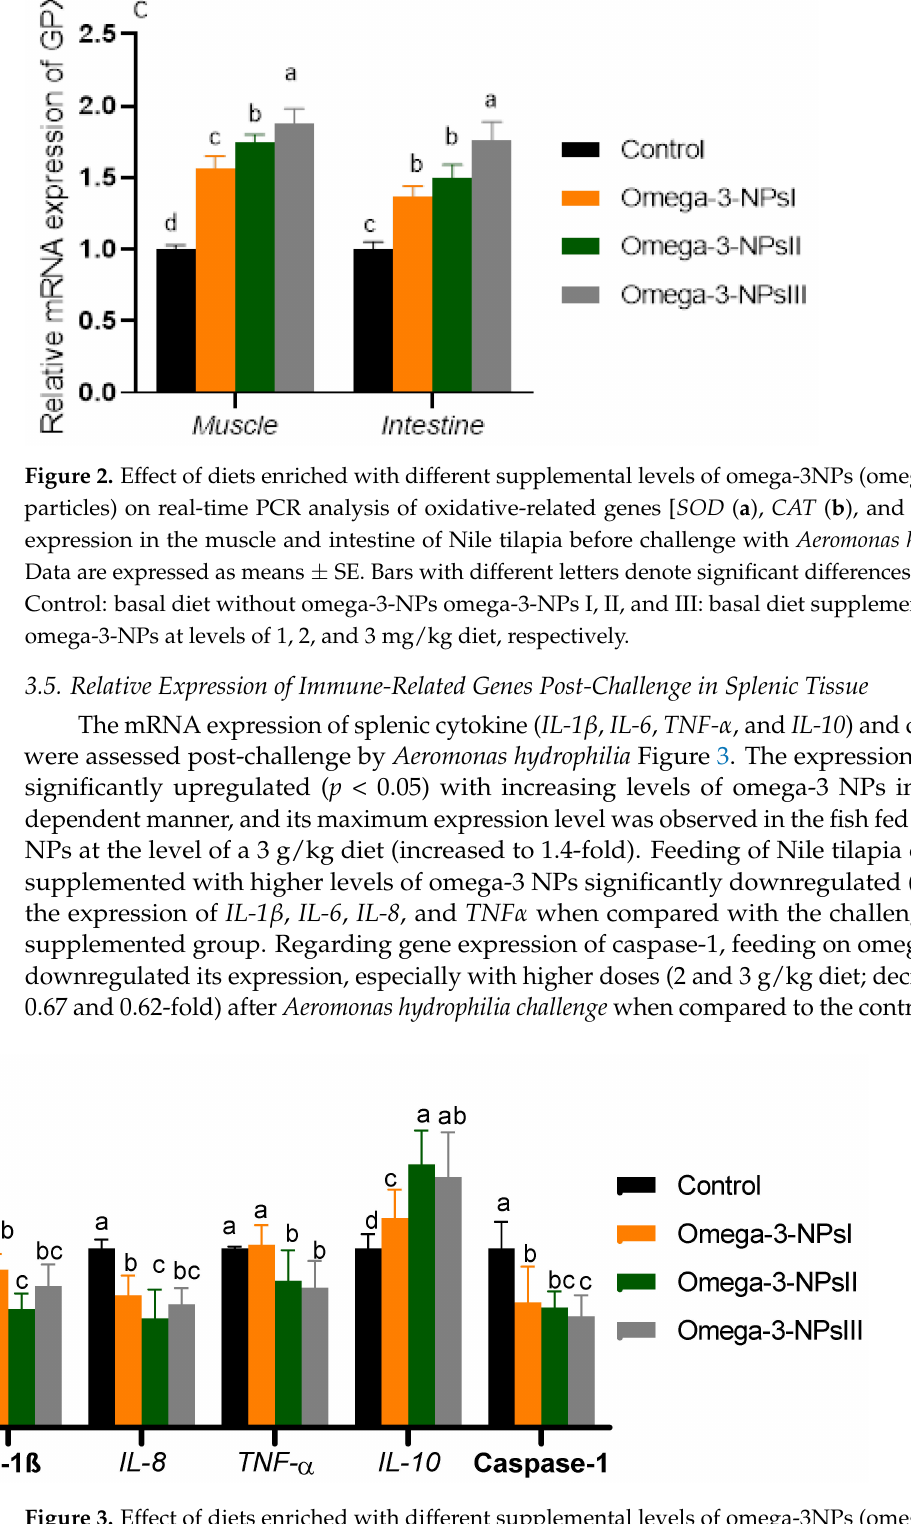
Figure 3. Effect of diets enriched with different supplemental levels of omega-3NPs (omega-3 nano particles) on real-time PCR analysis of immune-related genes [interleukin ( IL ) -1 β , IL-8 , IL-10 and tumor necrosis factor α ( TNF α ) in Nile tilapia post-challenge with Aeromonas hydrophila . Data are expressed as means ± SE. Bars with different letters denote significant differences ( p < 0.05). Control: basal diet without omega-3-NPs omega-3-NPsI, II, and III: basal diet supplemented with omega-3-NPs at levels of 1, 2, and 3 mg/kg diet,